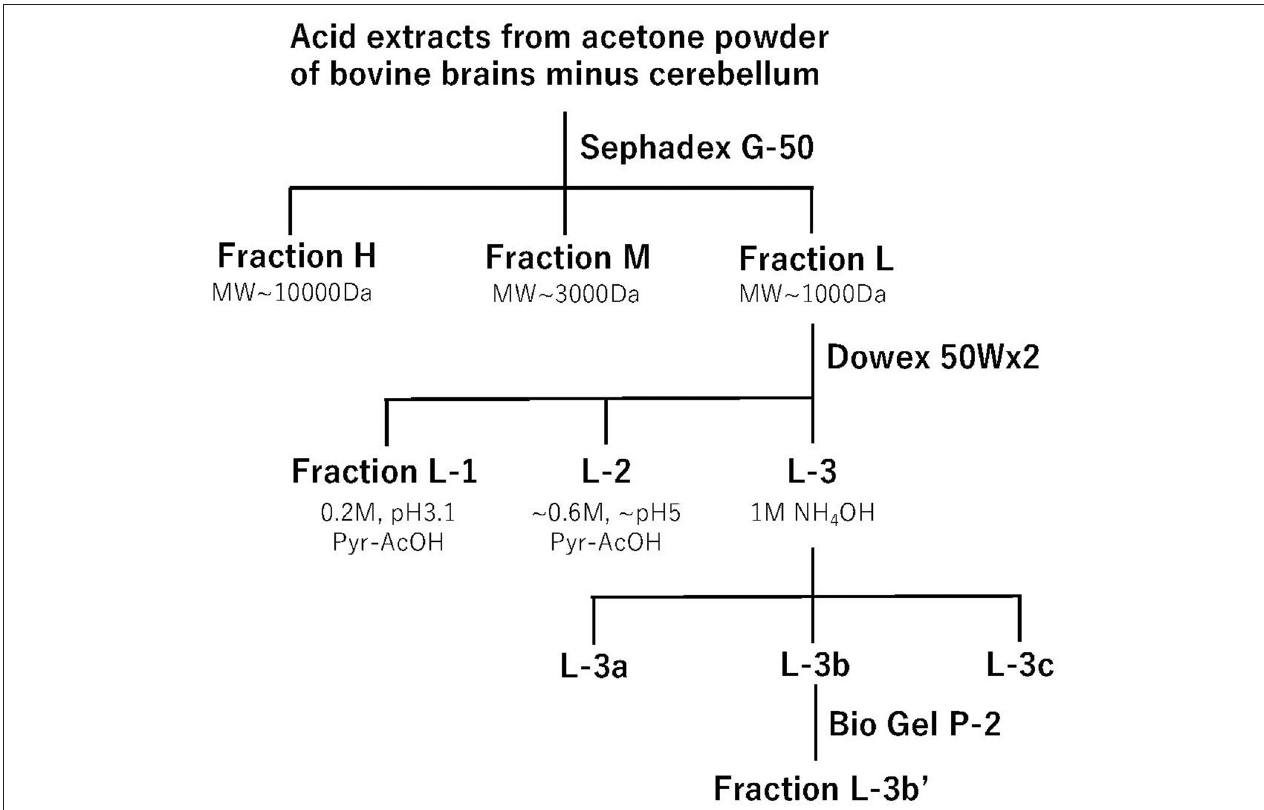
FIGURE 1 | Step-wise purification of kyotorphin. Acid extracts from acetone powder of bovine brains minus cerebellum were applied to a Sephadex G-50 gel filtration chromatography. Opioid-like analgesic activity was observed in three fractions, and the materials in low molecular fraction (Fraction L) were then separated by a Dowex 50Wx2 cation exchange chromatography. Among 28 fractions, opioid analgesic activity was observed in 5 fractions. Among them, the basic fraction L-3b showed the most potent and relatively long-lasting opioid-like analgesic activity. The material L-3b’ separated by the final BioGel P-2 gel-filtration chromatography was used for the amino acid sequence